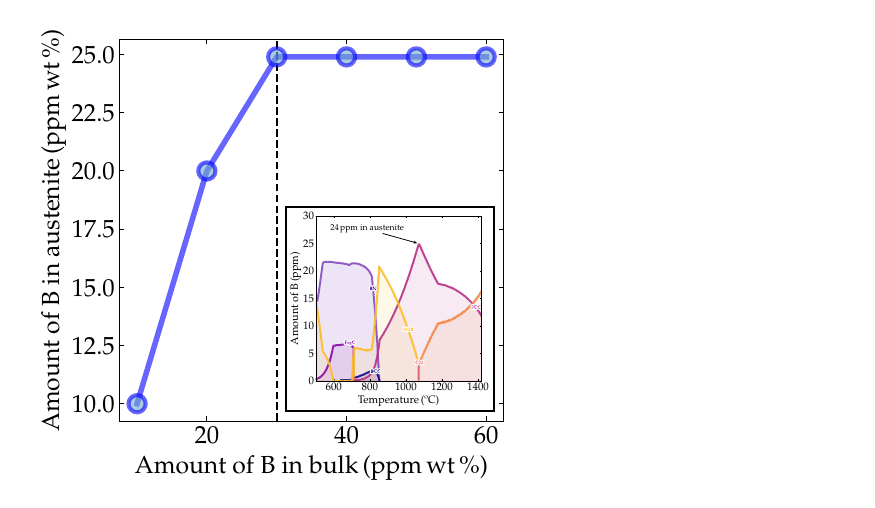
Figure 2. Thermodynamic prediction of boron in austenite as a function of the bulk composition. The inset depicts the thermodynamic simulation of the boron content in different microconstituents as a function of temperature, showing a broad peak around 24.9 ppm boron solubility in austenite for the bulk (Nb,B)-microalloyed steel. The calculations were performed using Thermocalc® with the TCFE11-21b database.